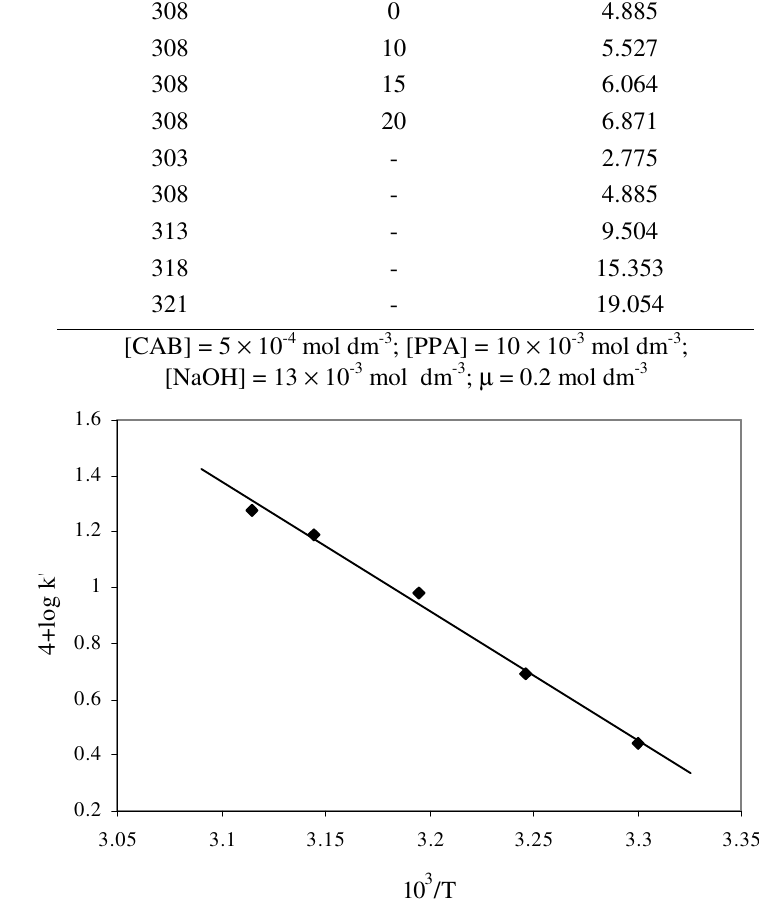
Figure 3. Plot of 4+log k' versus 10 3 /T